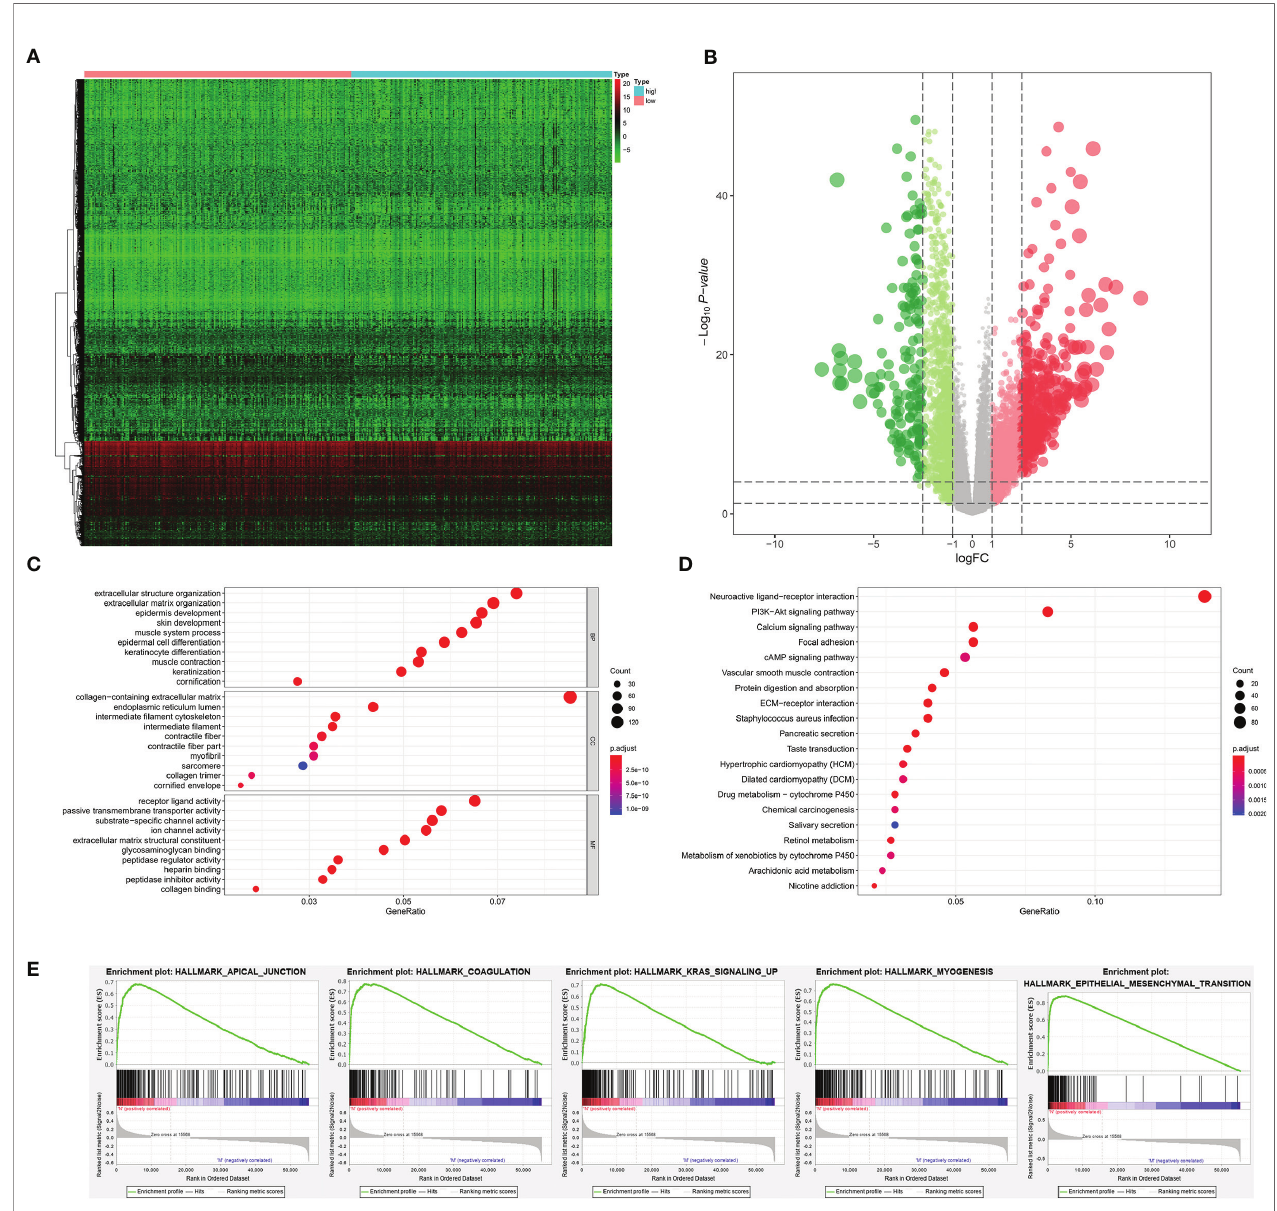
FIGURE 4 | The results of differential expression genes analysis and functional enrichment analysis between low mRNAsi BLCAs and high mRNAsi BLCAs: The heatmap (A) and volcano plot (B) of the differential expressed genes. The GO (C) , KEGG (D) , and (E) top fi ve GSEA enriched terms for the differential expressed